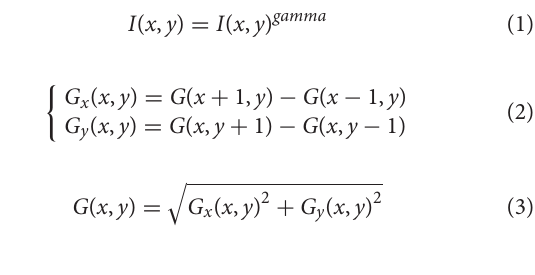
of light factors, the image matrix was normalized by contrast enhancement with a gamma variation obtained from Equation (1). The horizontal and vertical gradients of the image at the pixel point G(x, y) were calculated by Equation (2). Subsequently, the image was divided into small connected areas called cells. The gradient magnitude and orientation for each cell was calculated by Equation 3 and Equation